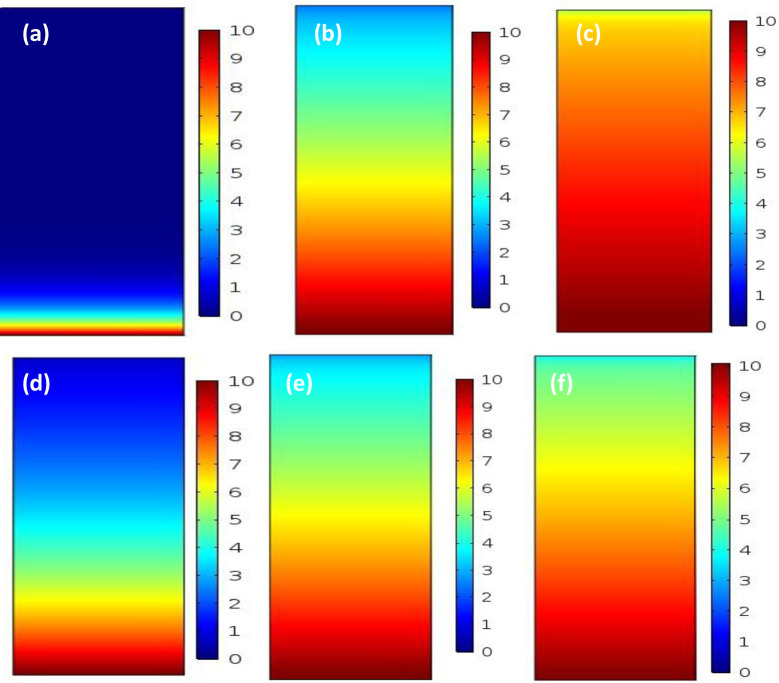
CO2 concentration gradient through the hydrophobic microporous membrane contactor using a) DEAB, b) EDA, c) EEA, d) MEA, e) MDEA, f) TEA absorbents.